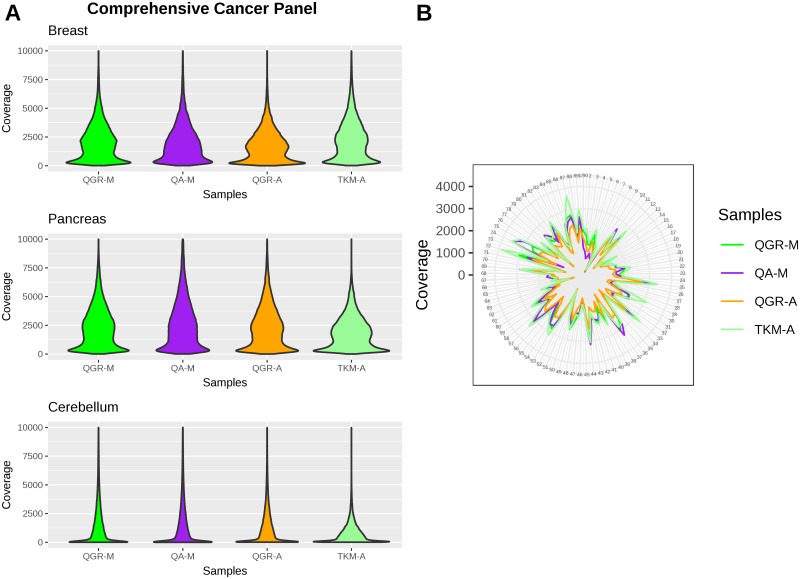
Raw coverage distribution for the four DNA extraction methods.A) Across all targeted bases as seen with the Comprehensive Cancer Panel and B) Across a random subset of the targeted regions in the Comprehensive Cancer Panel. The number 1–98 represent a random set of 98 targeted regions. The CIRCOS plot represents the regions targeted; the coverage lines within are noted on the left (0X the inner most to 4000X the outer most concentric lines).